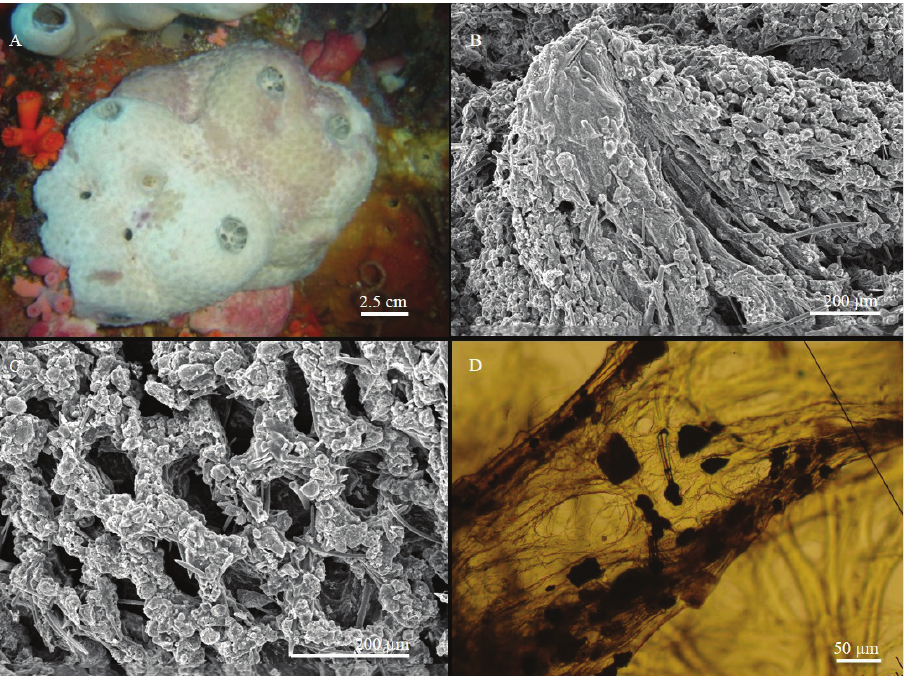
Figure 9. Psammocinia alba sp. n. A the sponge in situ B a small conule at SEM C reticulation made of sand grains and foreign spicules D primary fibres cored with foreign material and, on the right, secondary fibres free from